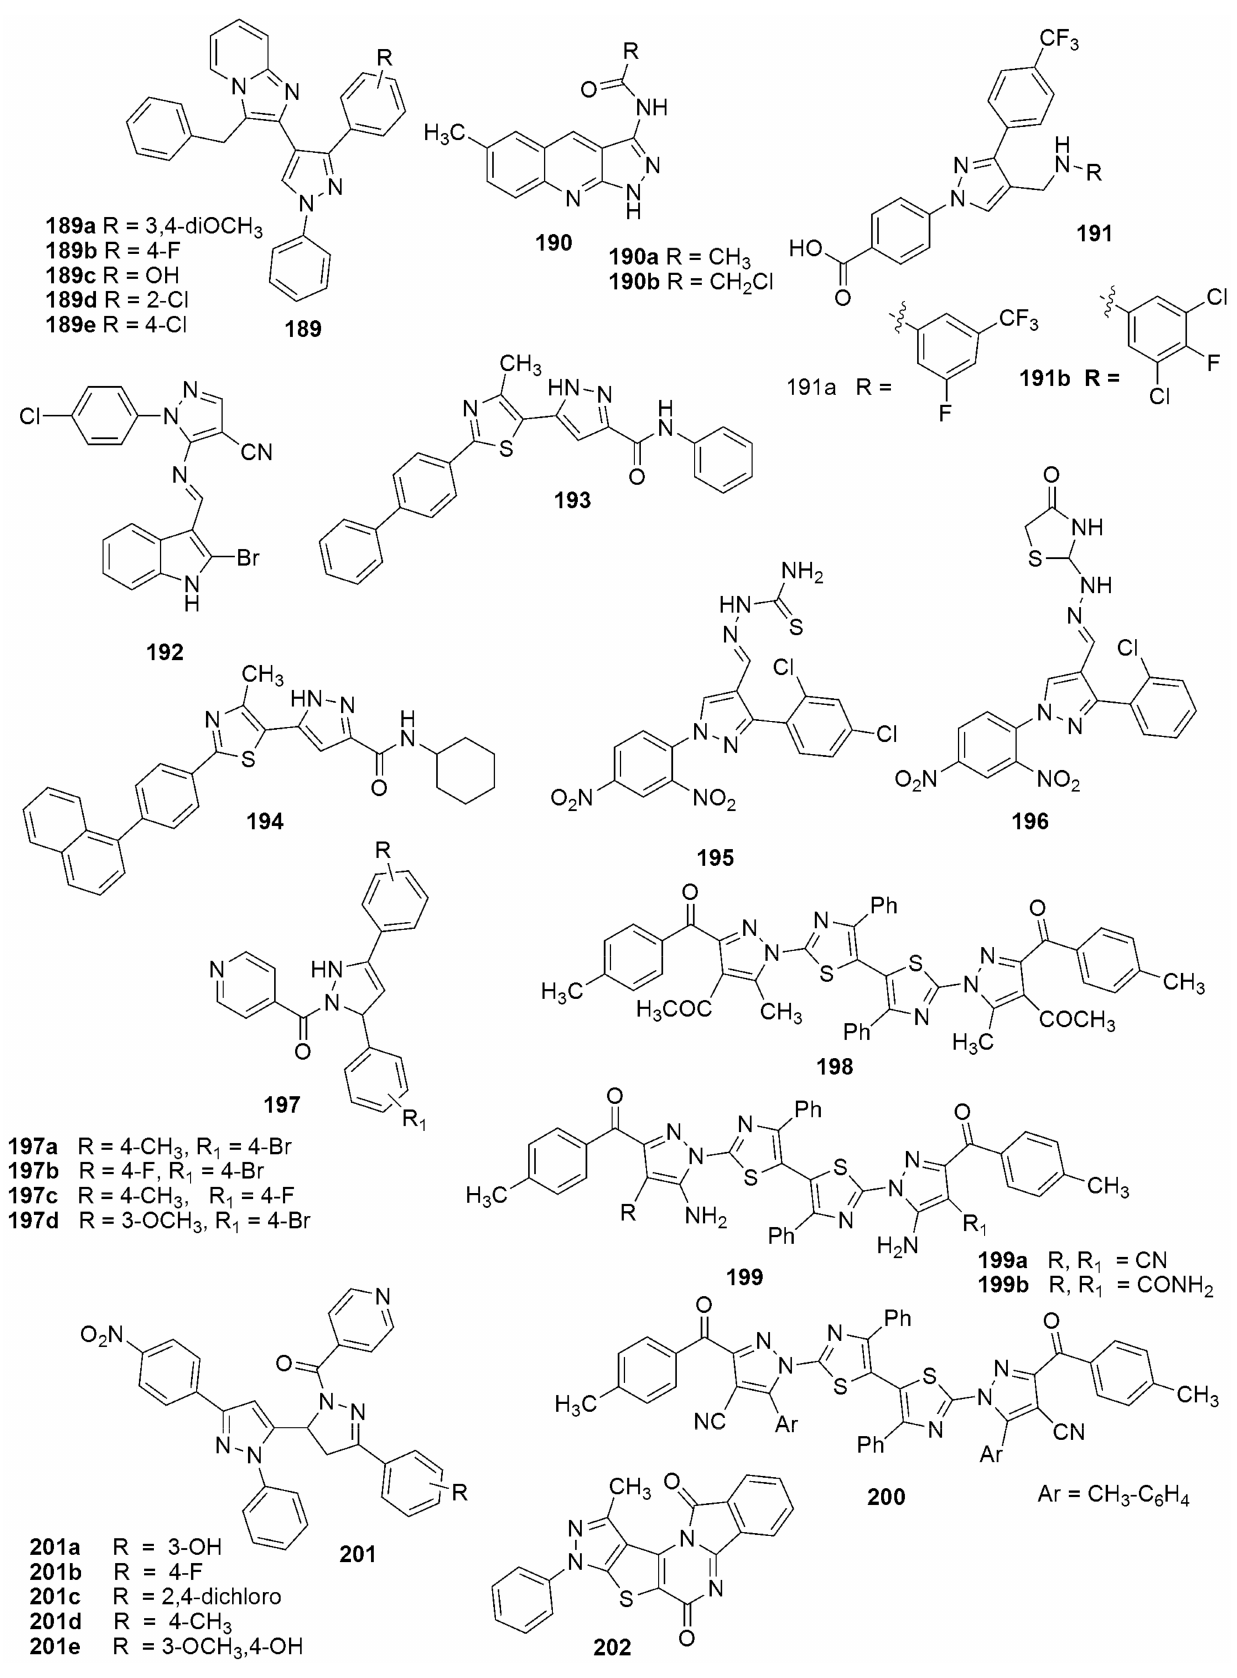
Figure 9. Structures of promising pyrazole derivatives with antibacterial